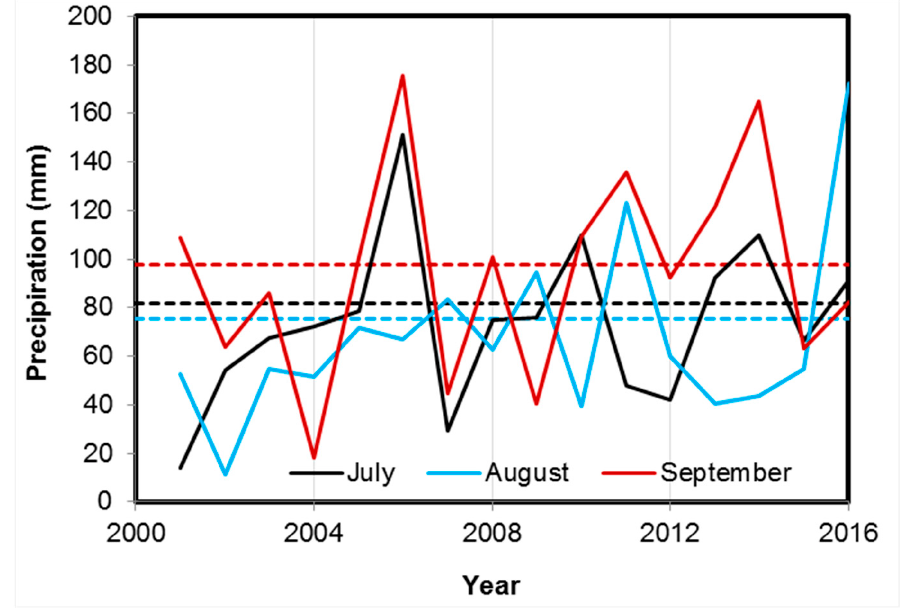
Figure 10. Monthly precipitation for July–September from the weather station at London, Ontario (Station identifier: 6144475), versus correspondent long term normals from 1985 to 2016 shown with the same color but in dashed